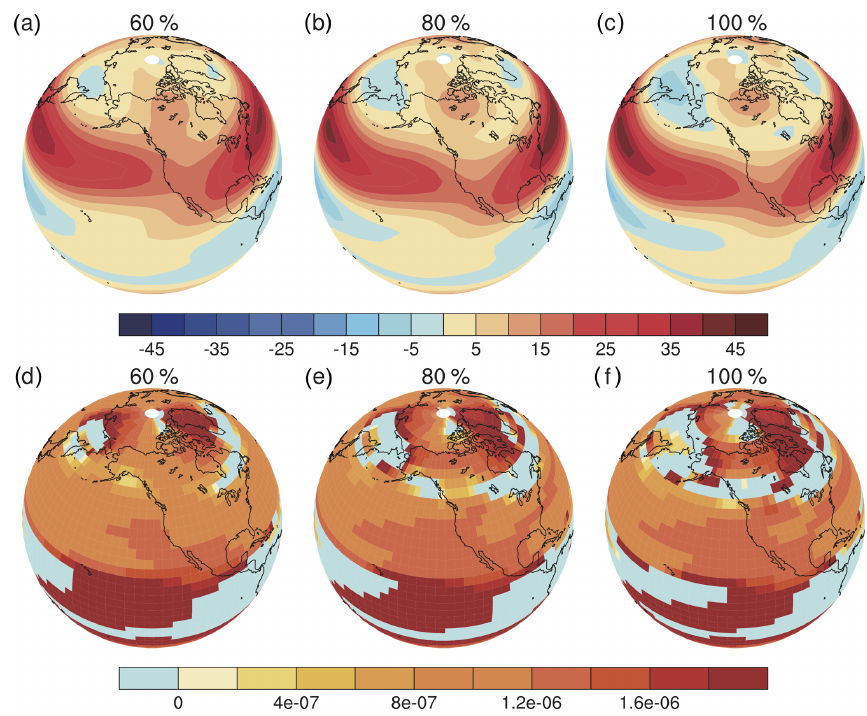
Figure 7. Distributions of zonal winds and stationary wave numbers for different ice sheet thicknesses in sensitivity simulations in DJF. (a–c) : Zonal winds; (d–f) : stationary wave numbers. (a, d) 60%, (b, e) 80% and (c, f) 100%. The zonal-wind unit is meters per second and the stationary wave number unit is per meter. The light-blue areas in (d-f) have imaginary wave numbers.